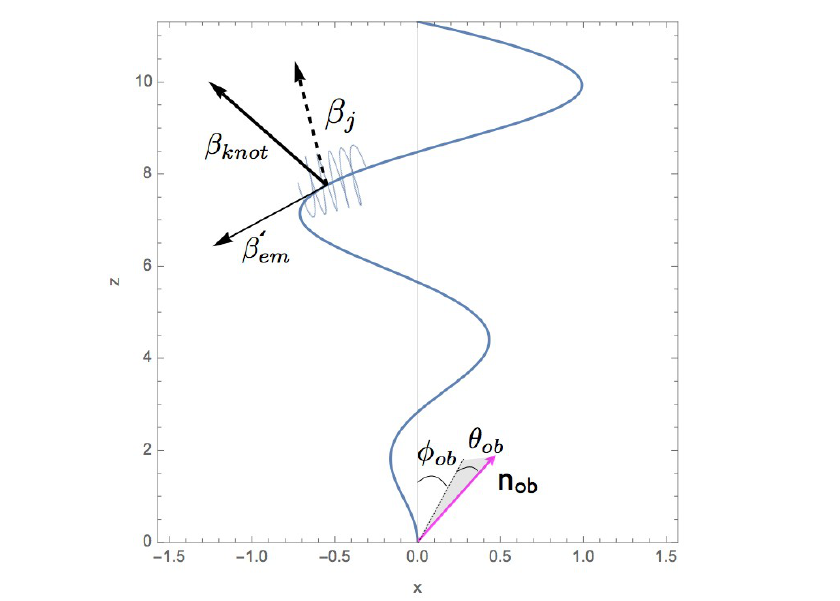
Figure 1. Schematic representation of the model. The jet is emitted along a variable direction (defined, e.g., by the opening angle of the planar motion, the jet’s oscillation angle). The solid line is a snapshot of the jet at a given moment. Pictured is the shape of the jet at some moment t . The internal helical structure of the magnetic field within the jet is aligned with the local jet direction, and changes with time. The physical motion of the jet’s fluid is with velocity β j along a ballistic trajectory (dashed arrow). In addition, a feature propagates along the instantaneous direction of the jet with velocity β (cid:48) em (thin arrow). We assume that the feature propagates toward the core (the origin) in the jet frame. The combined ballistic motion of the fluid and of the pattern along the jet results in the non-ballistic trajectory of a pattern. The total velocity of the knot is β knot —it is non-ballistic (velocity vectors do not form a closed triangle due to non-linearity of relativistic velocity addition). Direction to the observer n ob makes angle θ ob with the plane of the jet’s motions; projection of n ob onto the plane of the jet’s motion (thin dashed line) makes an angle φ ob with respect to the symmetry